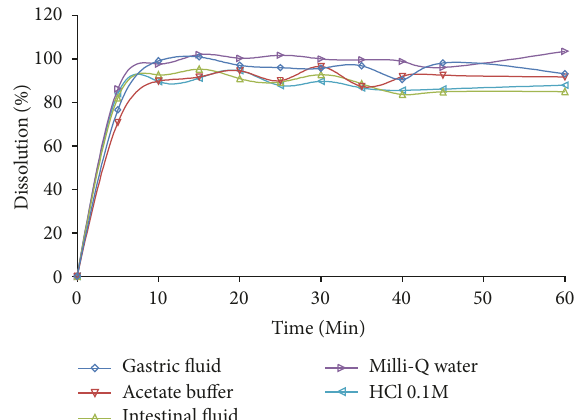
Figure2:DissolutionprofileofDAPAindifferentdissolutionmedia at 50